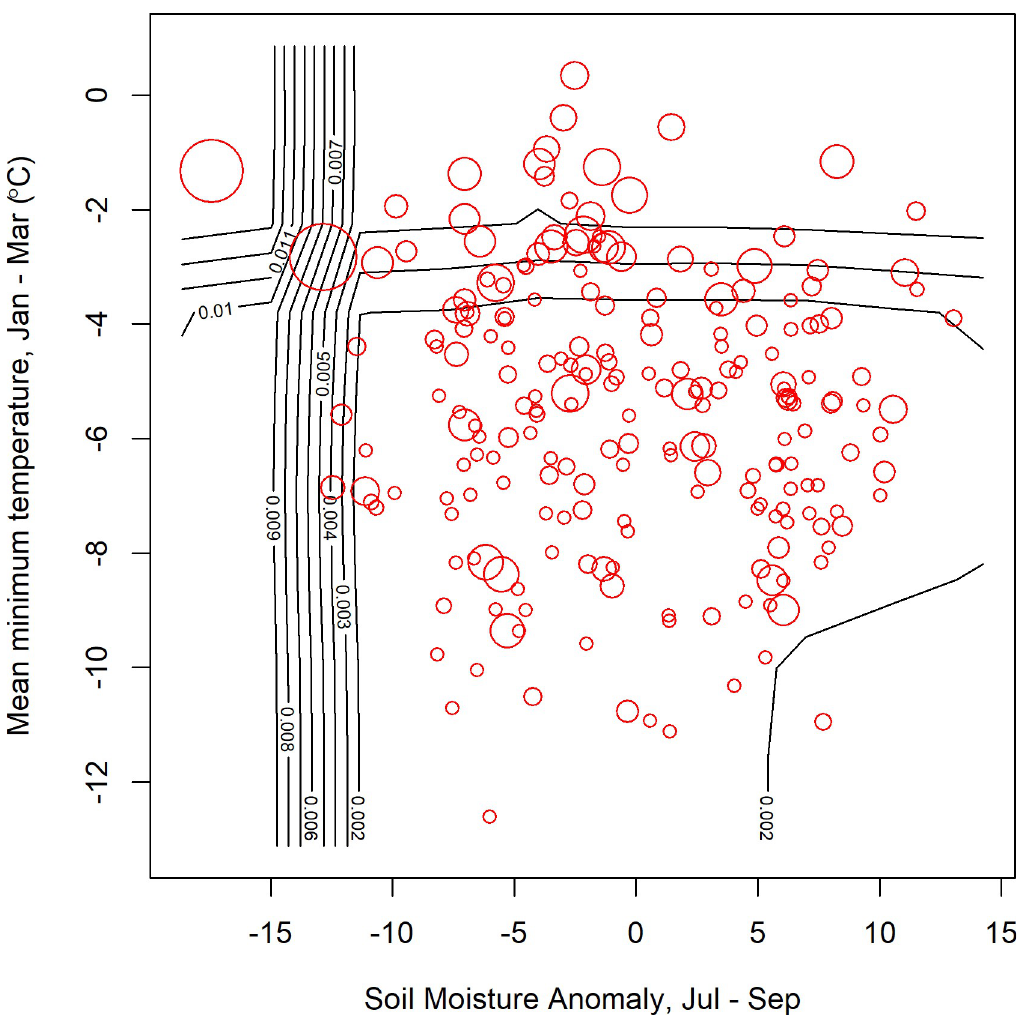
Fig 7. Warm winter temperatures and dry summers were associated with the highest risk of mosquito infection with WNV. Observations (red circles, size is proportional to infection rate) broadly support these predictions. Contour lines correspond to predictions made for a regular grid of 100 points covering the range of both variables. Predictions were made for mean values for all other covariates (see Tables 4 and 5 for included variables, see S1 File for mean values), while observed values correspond to the exact variable combinations and therefore may not exactly correspond to the predictions. Observations are plotted as a general guide to identify major patterns and highlight particular